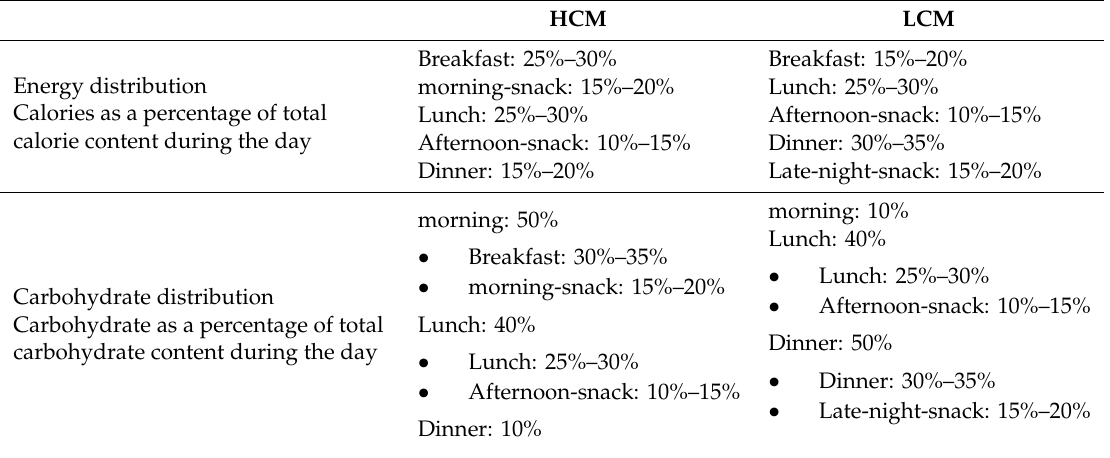
Table 2. Meal plan structure and diet compositions of HCM and